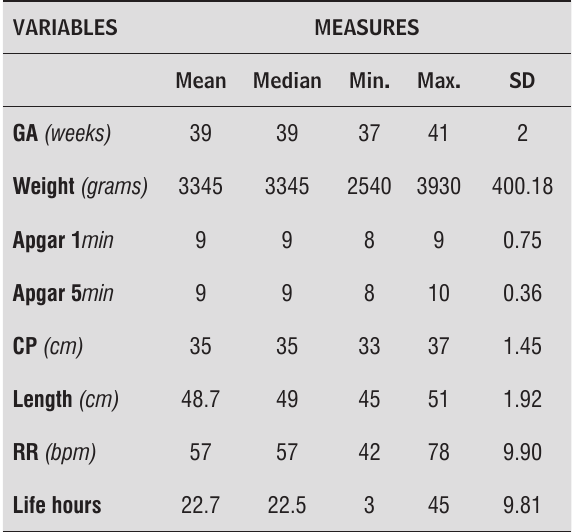
Table 1 - Characteristics of the studied population (n = 20) VARIABLES